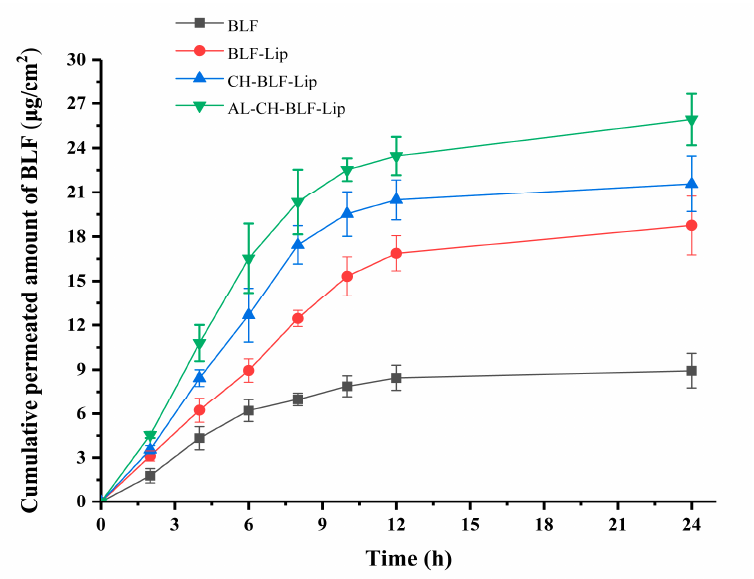
Figure 6. In vitro skin penetration of naked BLF and BLF releasing from different BLF-loaded nanoliposomes. Data were presented as mean ± SD of three independent replications. BLF, bamboo leaf flavonoids; BLF-Lip, BLF-loaded nanoliposomes; CH-BLF-Lip, BLF-loaded chitosan coated nanoliposomes; AL-CH-BLF-Lip, BLF-loaded alginate-chitosan coated nanoliposomes.